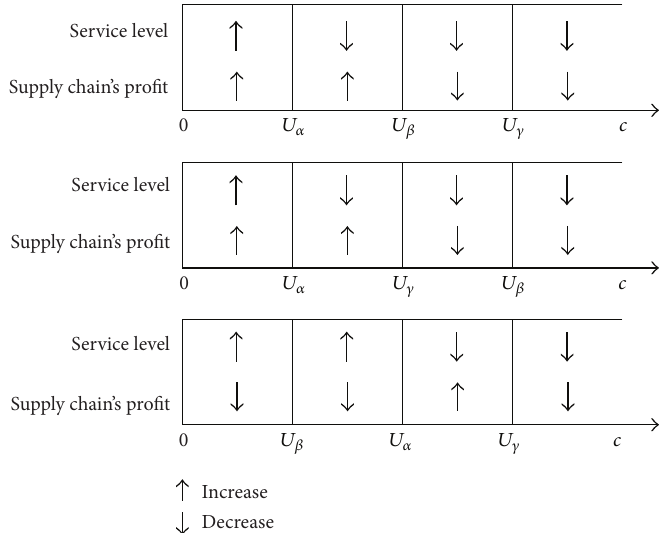
Figure 2: Service level and profit changes of the centralized supply chain with different costs of RFID tag. maximum expected profit of the retailer, supplier, and decen- tralized supply chain without adoption of RFID technology, respectively, recorded as 𝜋 ∗ 𝐷𝑟 (𝛼𝑄 ∗ 𝐷0 , 0) , 𝜋 ∗ 𝐷𝑠 (𝛼𝑄 ∗ 𝐷0 , 0) ,